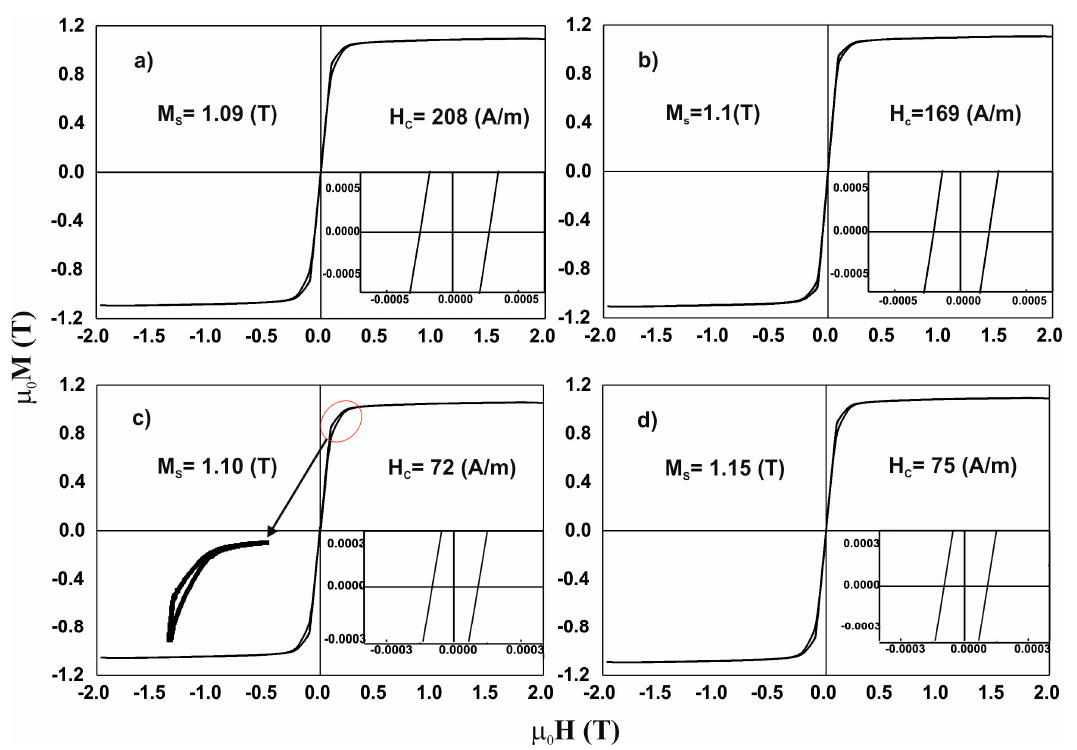
Figure 5. Static magnetic hysteresis loops for the alloys: ( a ) Fe 36 Co 36 Y 8 B 20 , ( b ) Fe 39 Co 33 Y 8 B 20 , ( c ) Fe 43 Co 29 Y 8 B 20 , ( d ) Fe 48 Co 24 Y 8 B 20 .